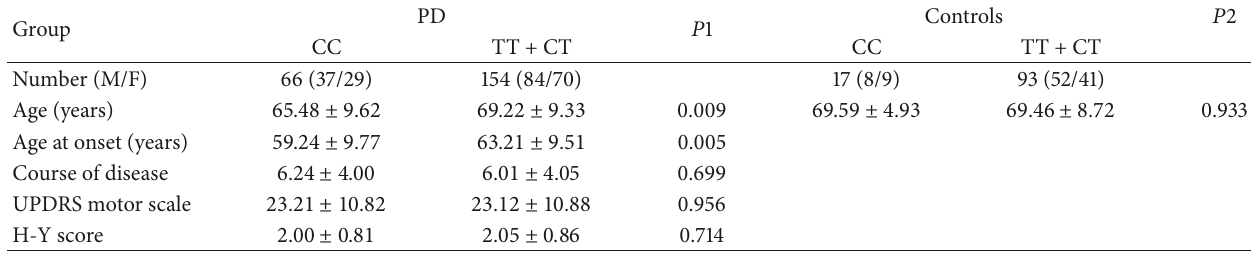
Table 1: Clinical characteristics of study participants. The mean onset age of PD patients with the rs1014290 CC genotype was lower than that of those with the TT + TC genotype.